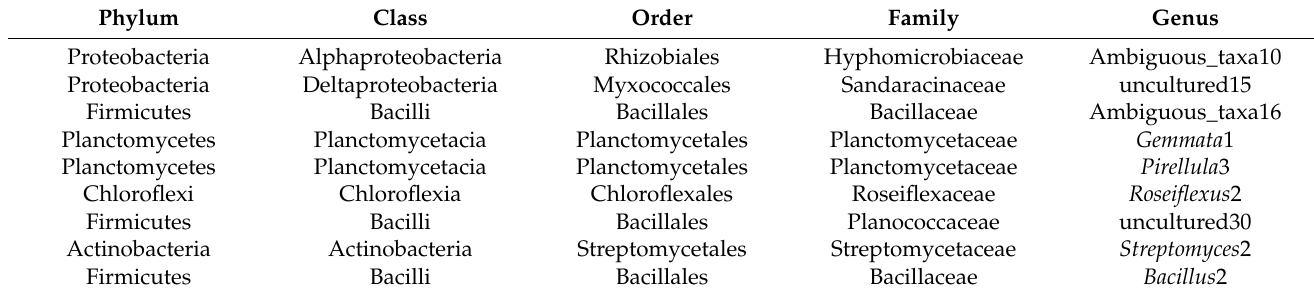
Table 3. Classification of bacterial genera that were significantly more abundant in the rhizosphere of the 15 soybean fields (sampled from the Highveld region, Mpumalanga province, South Africa) used in this study according to LefSe. Phylum Class